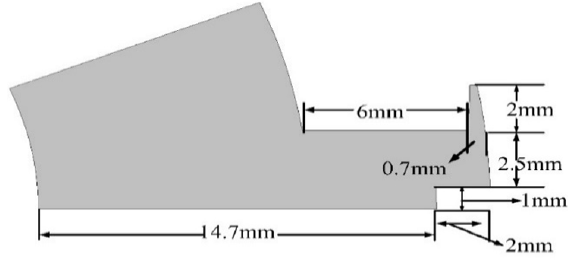
Figure 20. Hybrid (notch and flange) of the rotor pole.